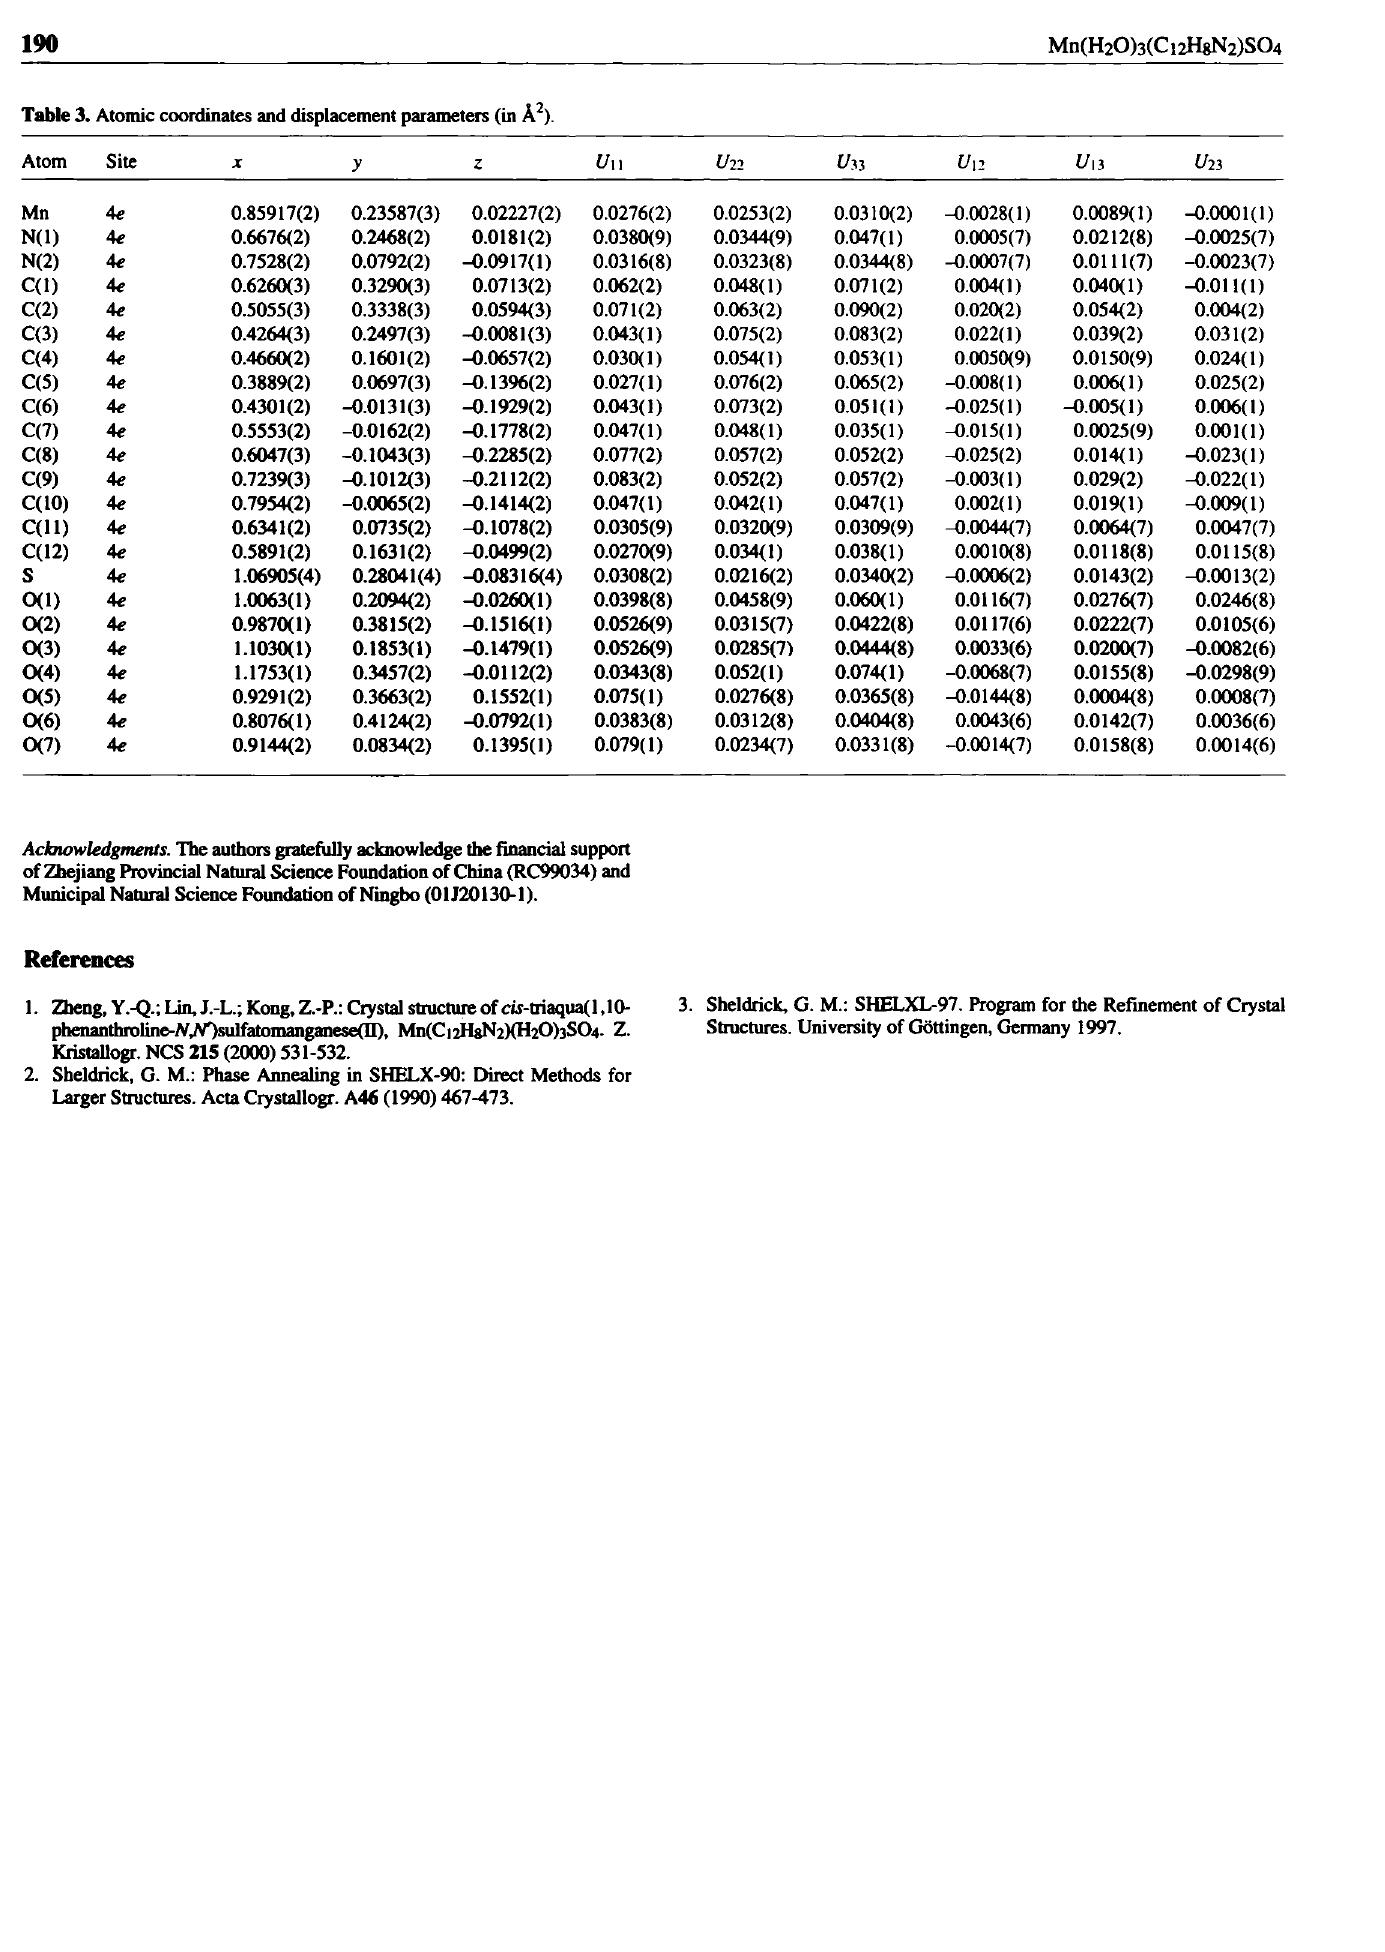
Table 3. Atomic coordinates and displacement parameters (in À 2